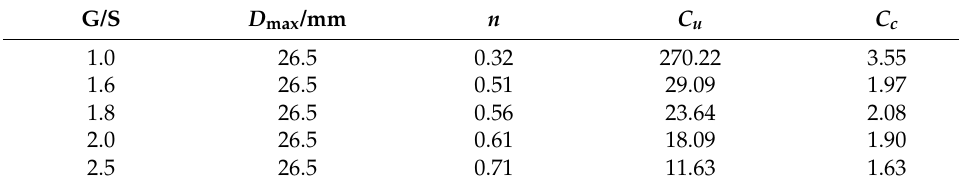
Table 1. Gradation design scheme and corresponding gradation